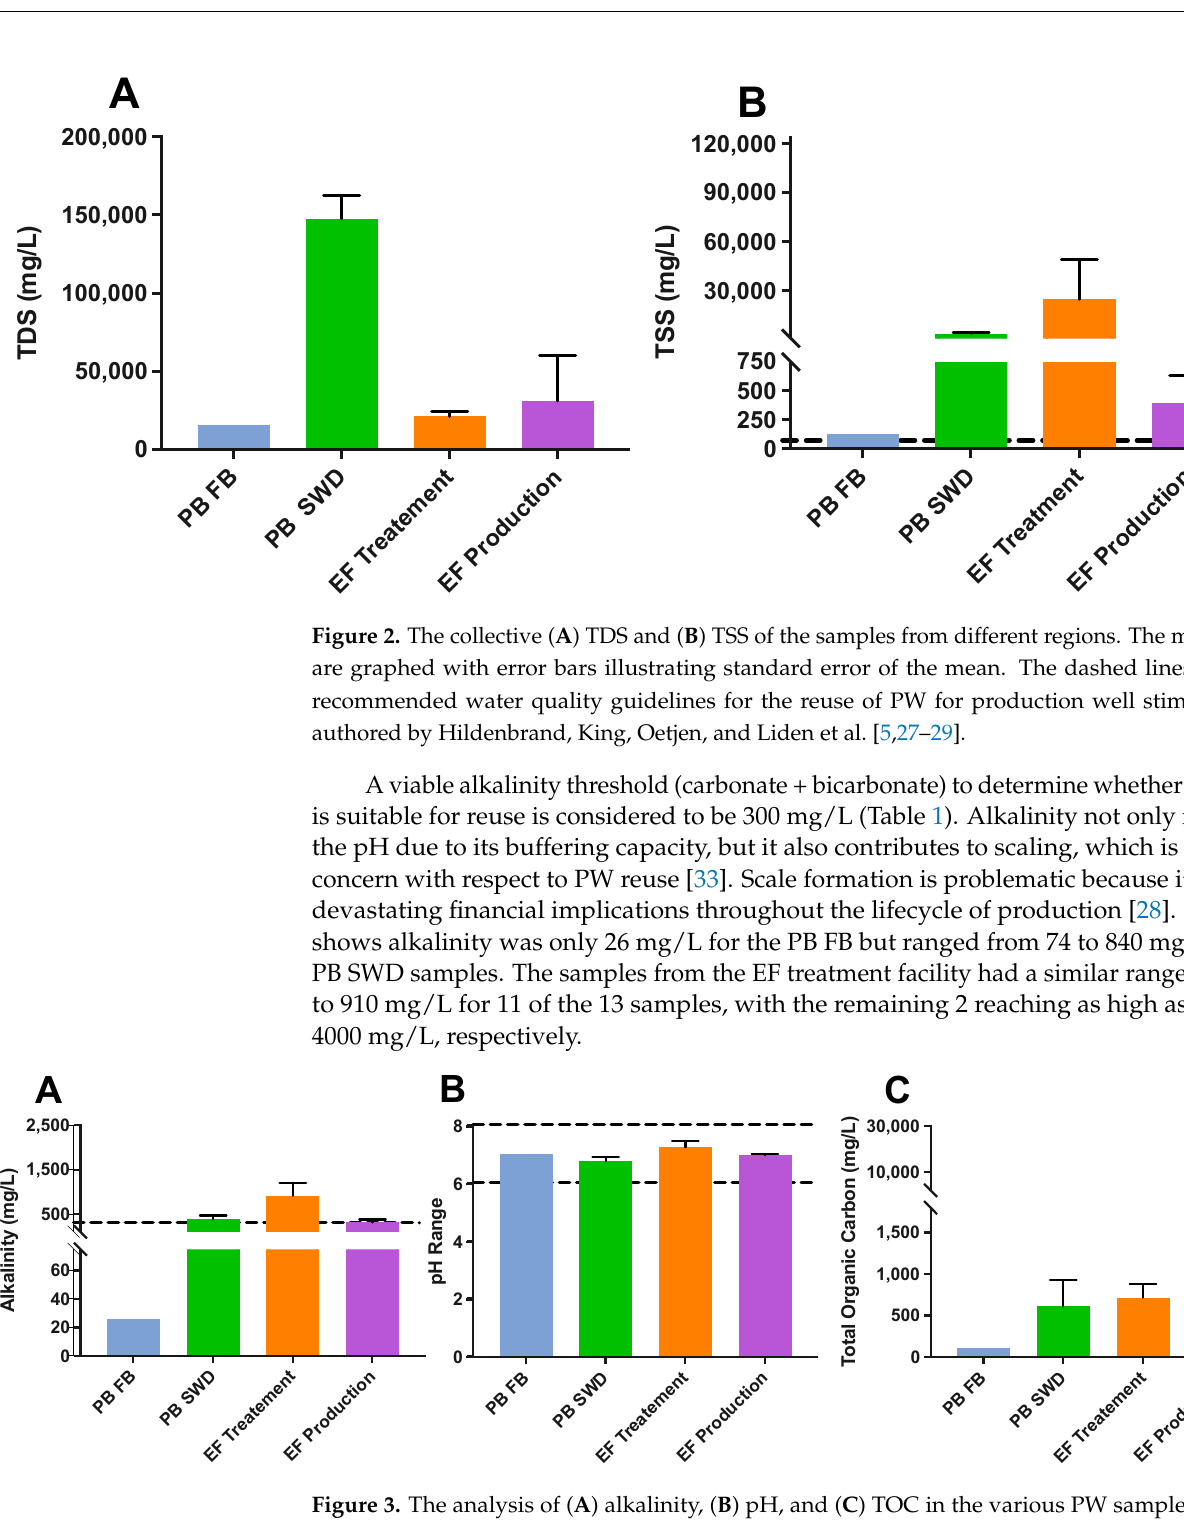
Figure 3. The analysis of ( A ) alkalinity, ( B ) pH, and ( C ) TOC in the various PW samples. Data are presented as mean values with the error bars representing standard error of the mean. The dashed lines represent recommended levels for the reuse of PW for production well stimulation authored by Hildenbrand, King, Oetjen, and Liden et al. [5,27–29].